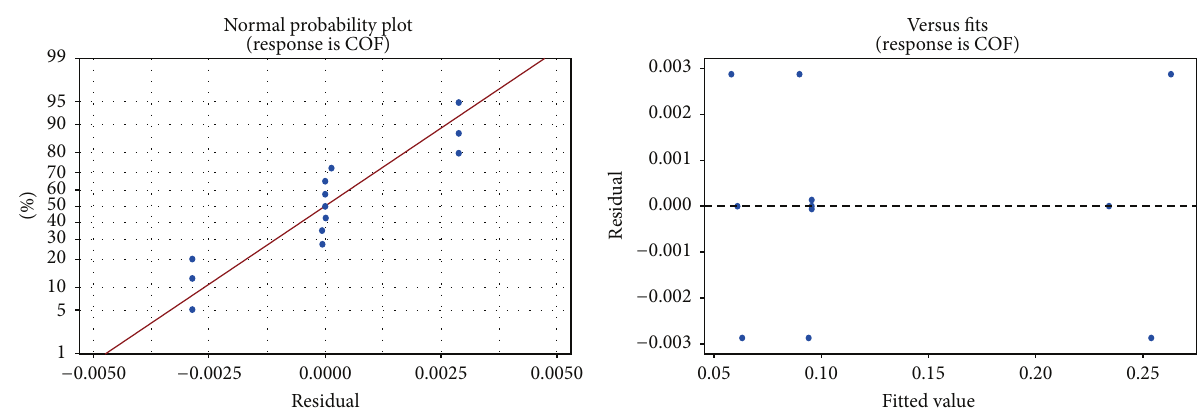
Figure 5: Normal probability plot and versus fits for average COF.